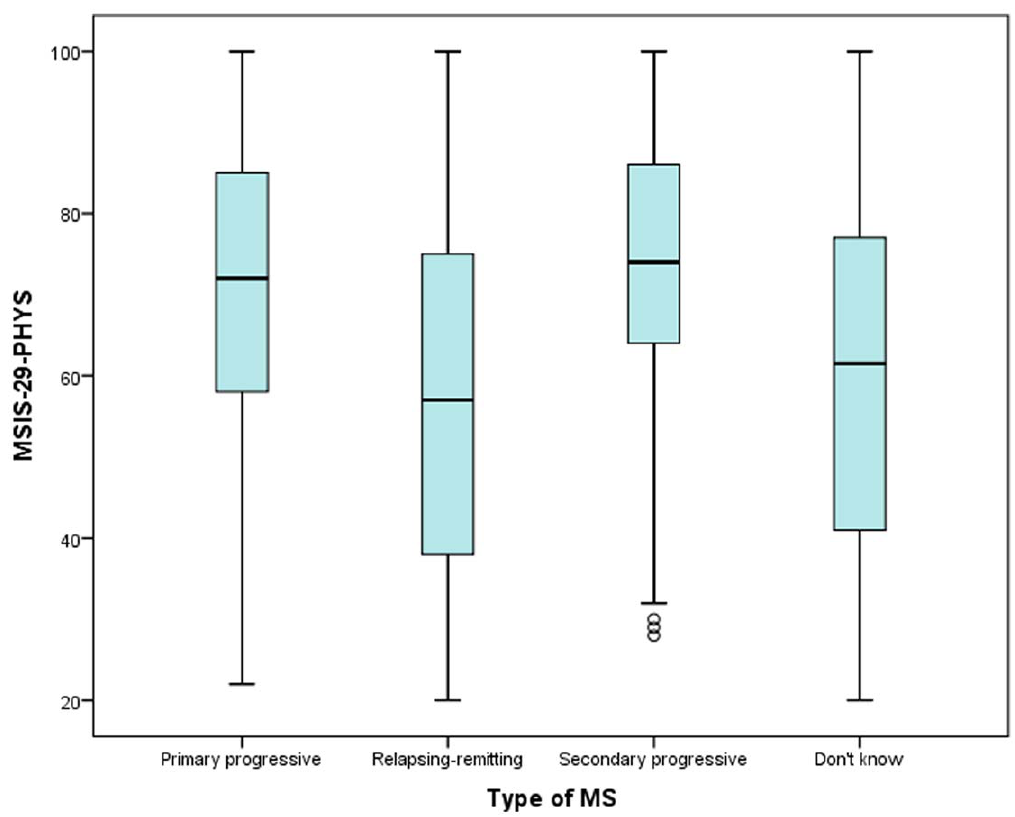
Figure 2. The MSIS-29-PHYS scores by type of MS. The relative MSIS-29-PHYS scores of people who report having different types of MS are indicated.